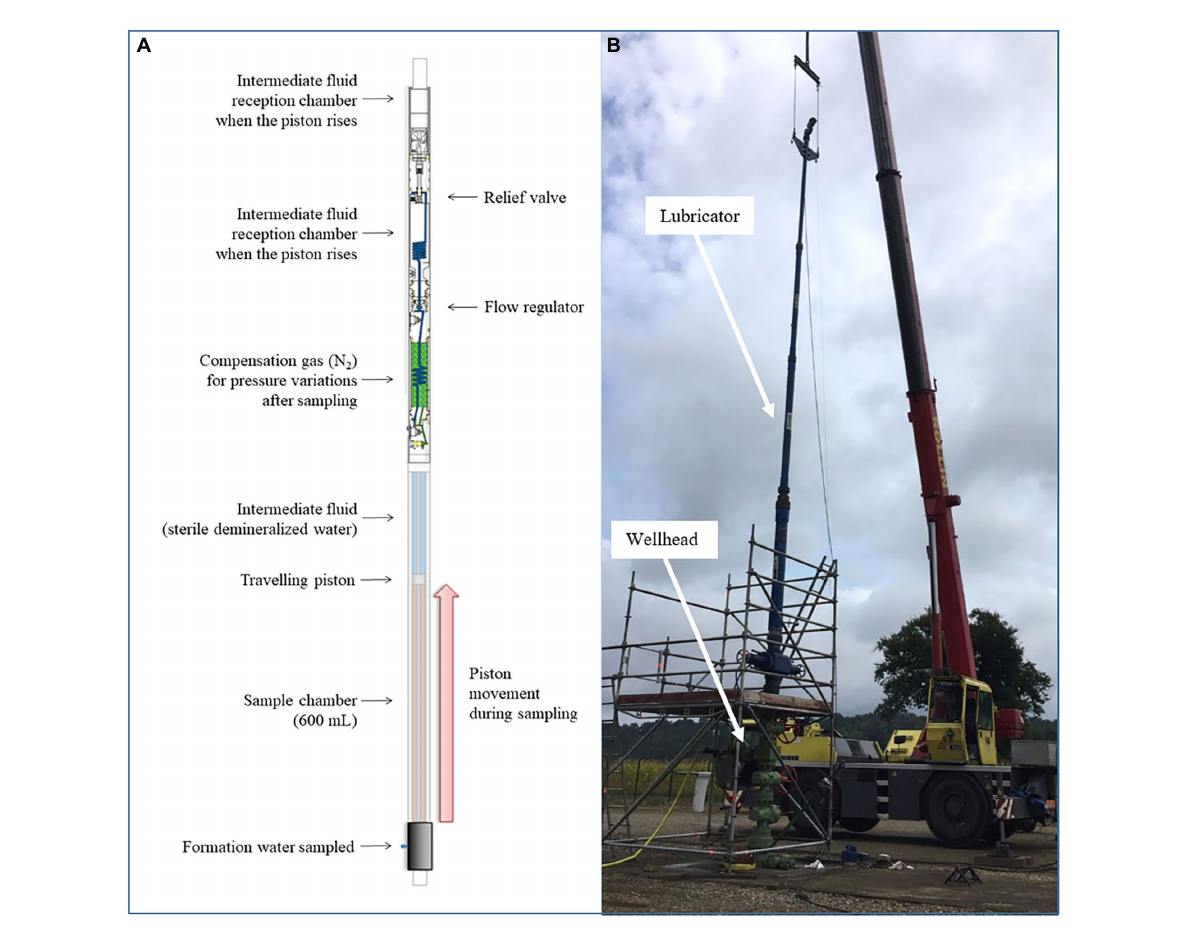
FIGURE 1 Use of the LEUTERT OPS downhole sampler to collect microorganisms from a deep aquifer. (A) Descriptive diagram of the downhole sampler; (B) Deployment of the sampler on site: the sampler is inserted into a chamber. Then, the chamber is connected to the wellhead before it is opened, and the sampler descends into the